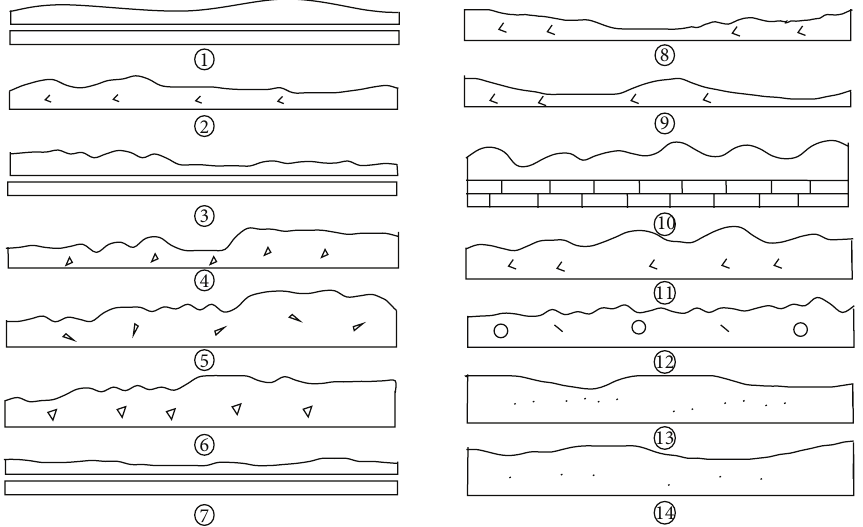
Figure 5: Typical profile curves of joint surface (sample size is 15 cm and scale is 1: 3). A Planar and smooth (carbonaceous slate foliation). B Planar and rough (plagioclase hornblendite joint). C Single stepped (phyllite joint). D Compound single stepped (volcanic breccia joint). E Multistepped (volcanic breccia joint). F Compound multistepped (volcanic breccia joint). G Undulating (carbonaceous slate foliation). H Undulating (plagioclase hornblendite joint). 0 Undulating (plagioclase hornblendite joint). 1 Undulating (calcilutite joint). 2 Compound undulating (mixed hornblendite joint). 3 Asymmetric undulating (breccia-bearing fusion tuff joint). 4 Asymmetric undulating (siltstone ripple bedding). 5 Symmetric undulating (siltstone ripple bedding).